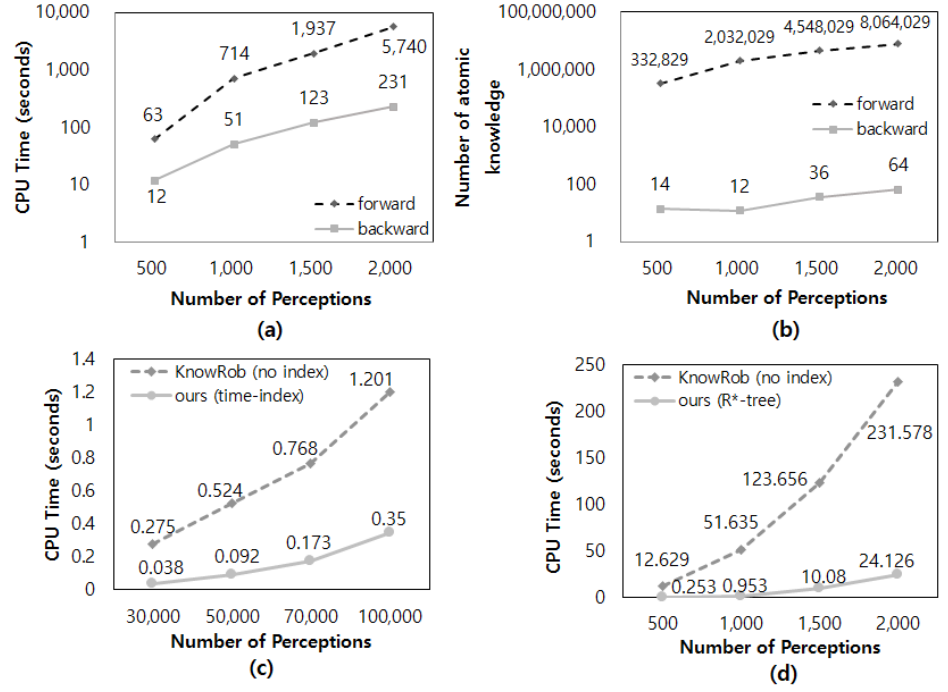
Figure 19. Experimental result of context query-processing by using reasoning types or spatio-temporal index ( a ) Reasoning time by reasoning types, ( b ) amount of inferred knowledge by reasoning types, ( c ) temporal query-processing time and ( d ) spatial query-processing time with respect to index.